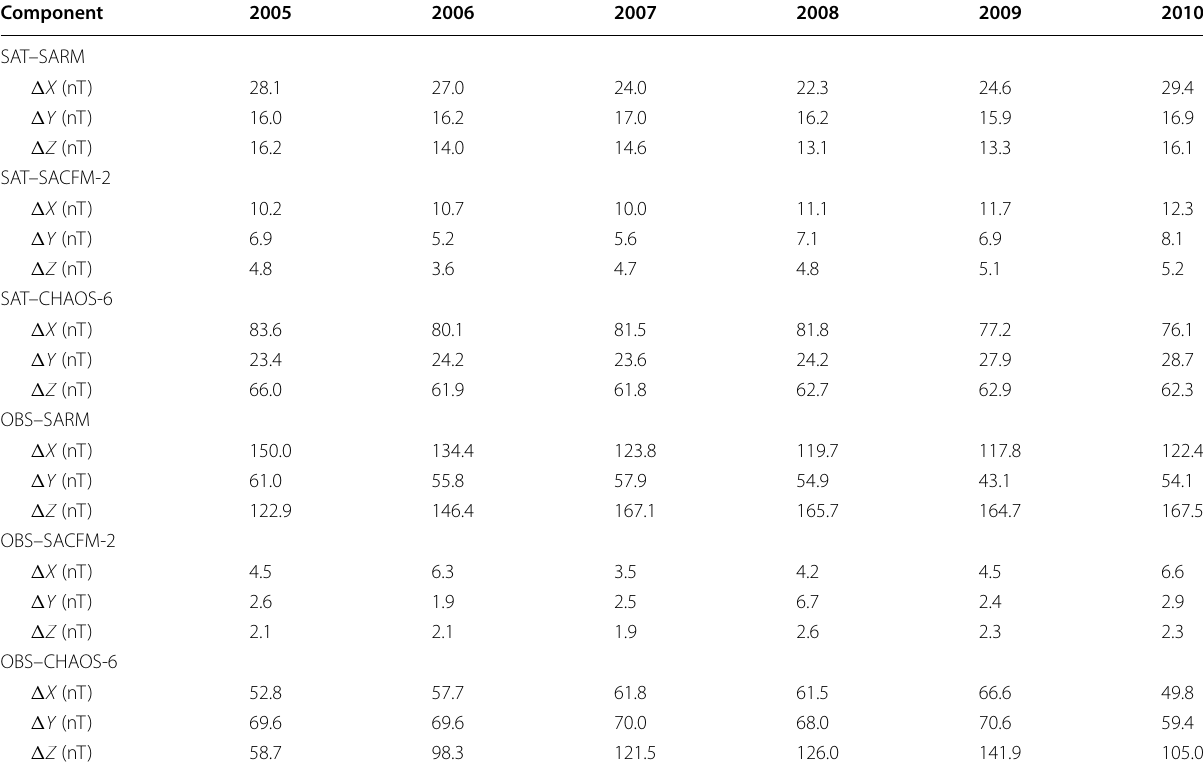
In 2005 and 2010, only the input satellite or observatory data recorded after 2005.5 and before 2010.5 were used, respectively